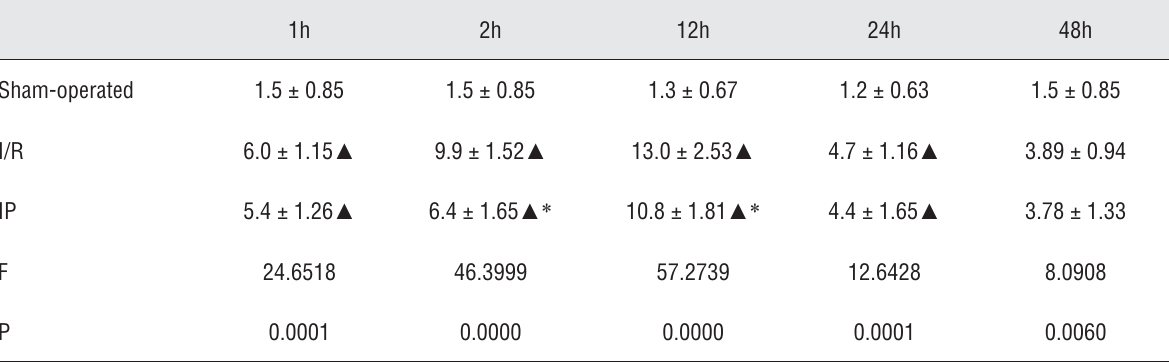
Table 2 - Effects of ischemic preconditioning on the expression of P-Selectin in rat kidney (positive cell number/HP).